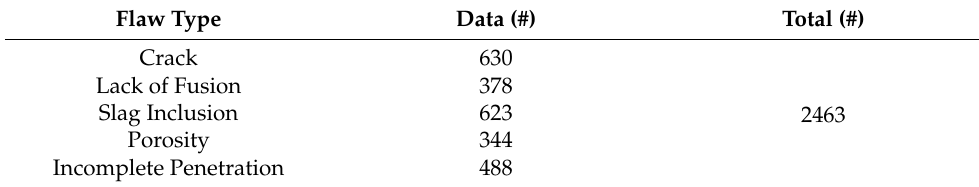
Table 2. Data acquired from the ultrasonic